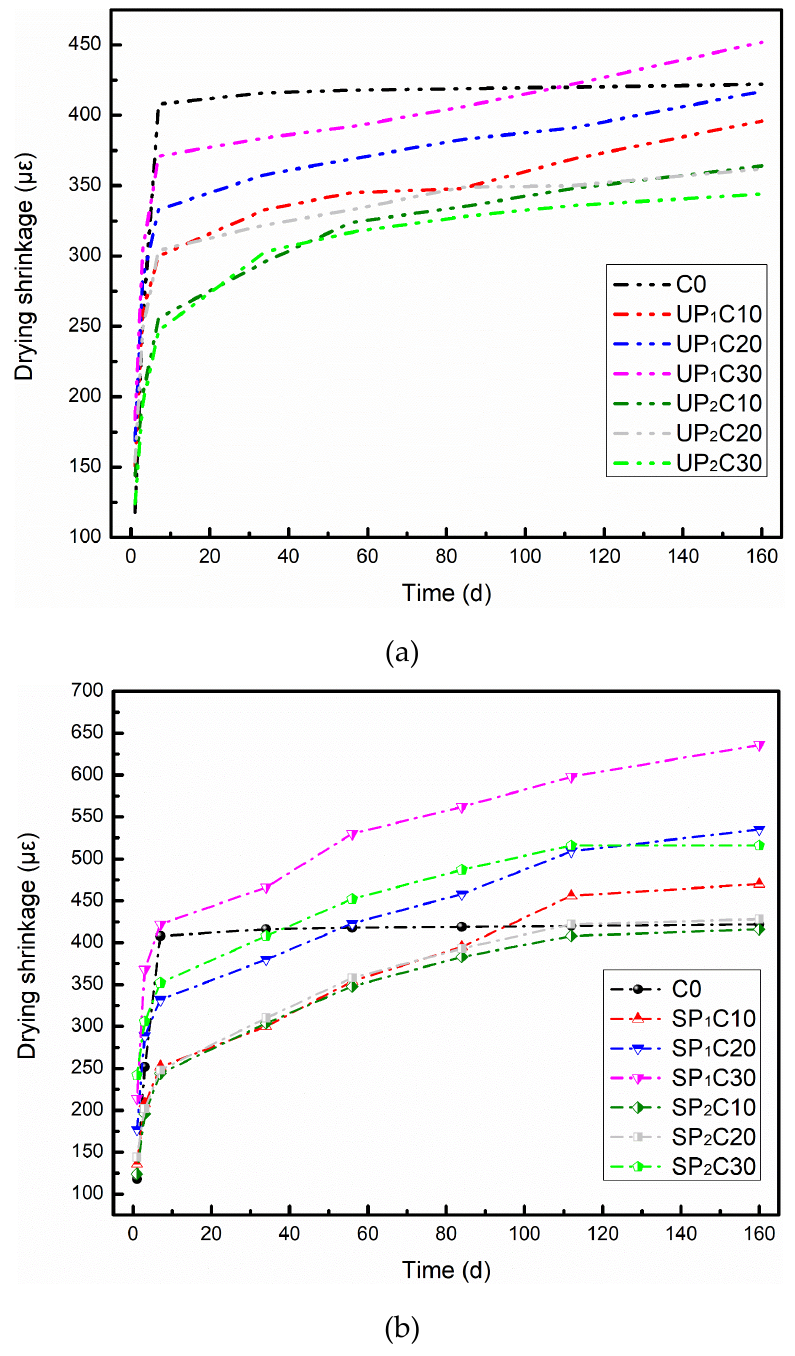
Figure 6. Influence of humid pumice on the persistent shrinkage deformation evolvement of the designed UHPC: ( a ) unsaturated pumice substitution; ( b ) saturated pumice substitution. 348